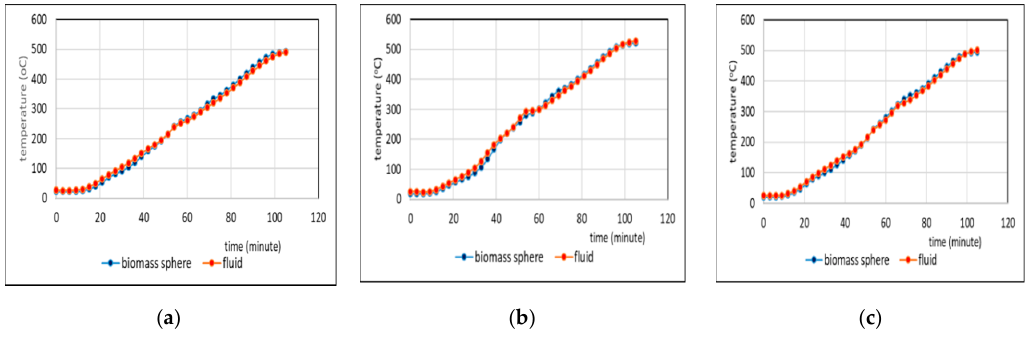
Figure 3. Comparison of temperatures of biomass spheres and biomass pyrolysis fluid taken at thermocouple #3 ( a ), thermocouple #4 ( b ), thermocouple #5 ( c ).